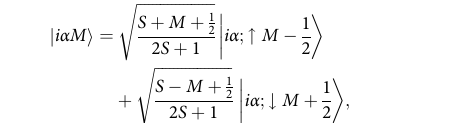
ffiffiffiffiffiffiffiffiffiffiffiffiffiffiffiffiffiffiffiffi